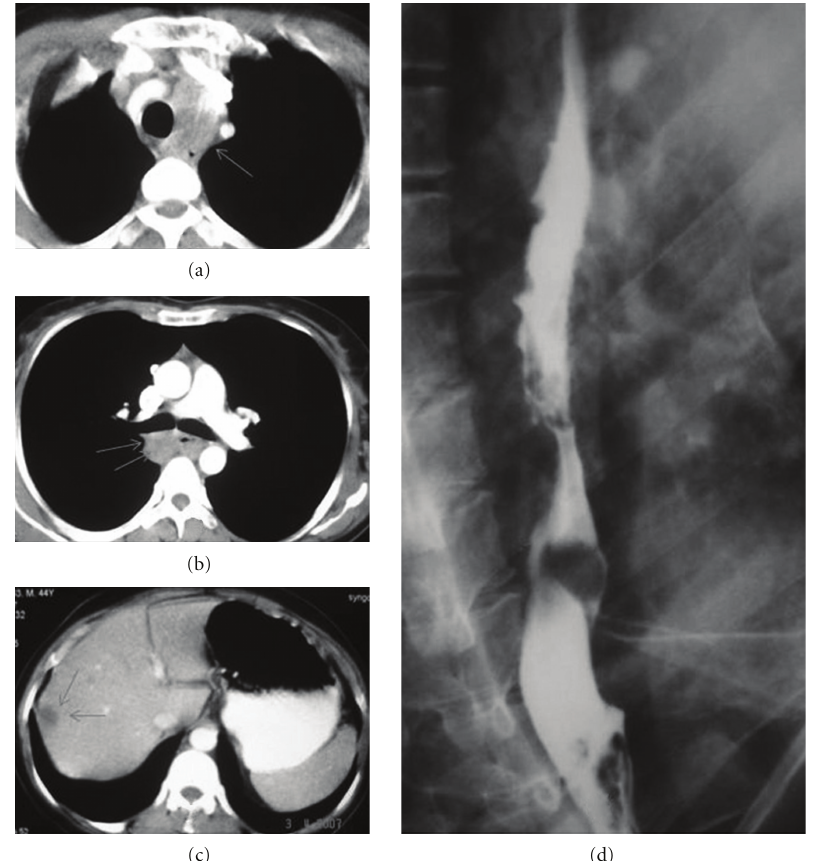
Figure 1: (a, b, c) Thorax CT revealed the multiple mediastinal lymph nodes up to 2-3cm and hepatic metastasis (arrows). (d) The barium- contrasted esophageal graphy is showing mucosal irregularity.